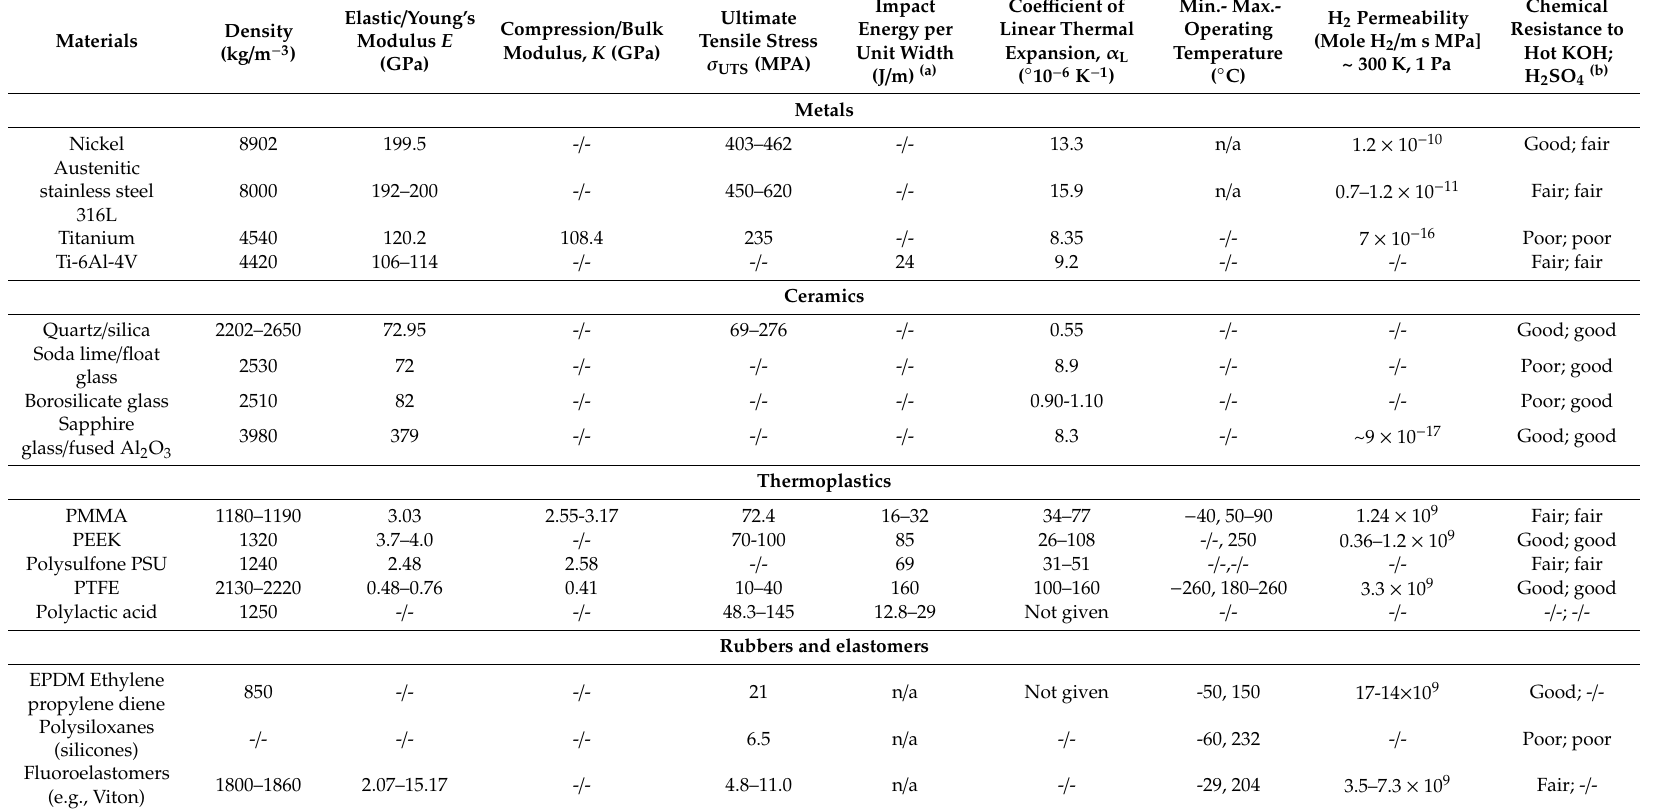
Table 2. Mechanical, thermal and chemical properties of materials that have been used in the past for electrolysers, fuel cells and photovoltaic modules. All data taken from Cardarelli [35] except for H 2 permeability of metals [36] and polymers